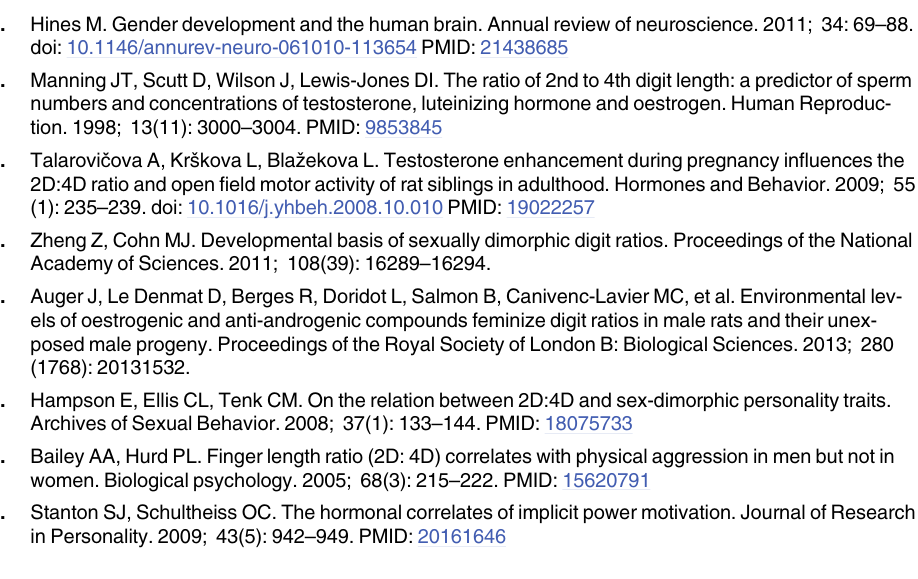
S1 Fig. Facial dominance manipulation. S2 Fig. Relationship between right hand 2D4D and dominance by facial